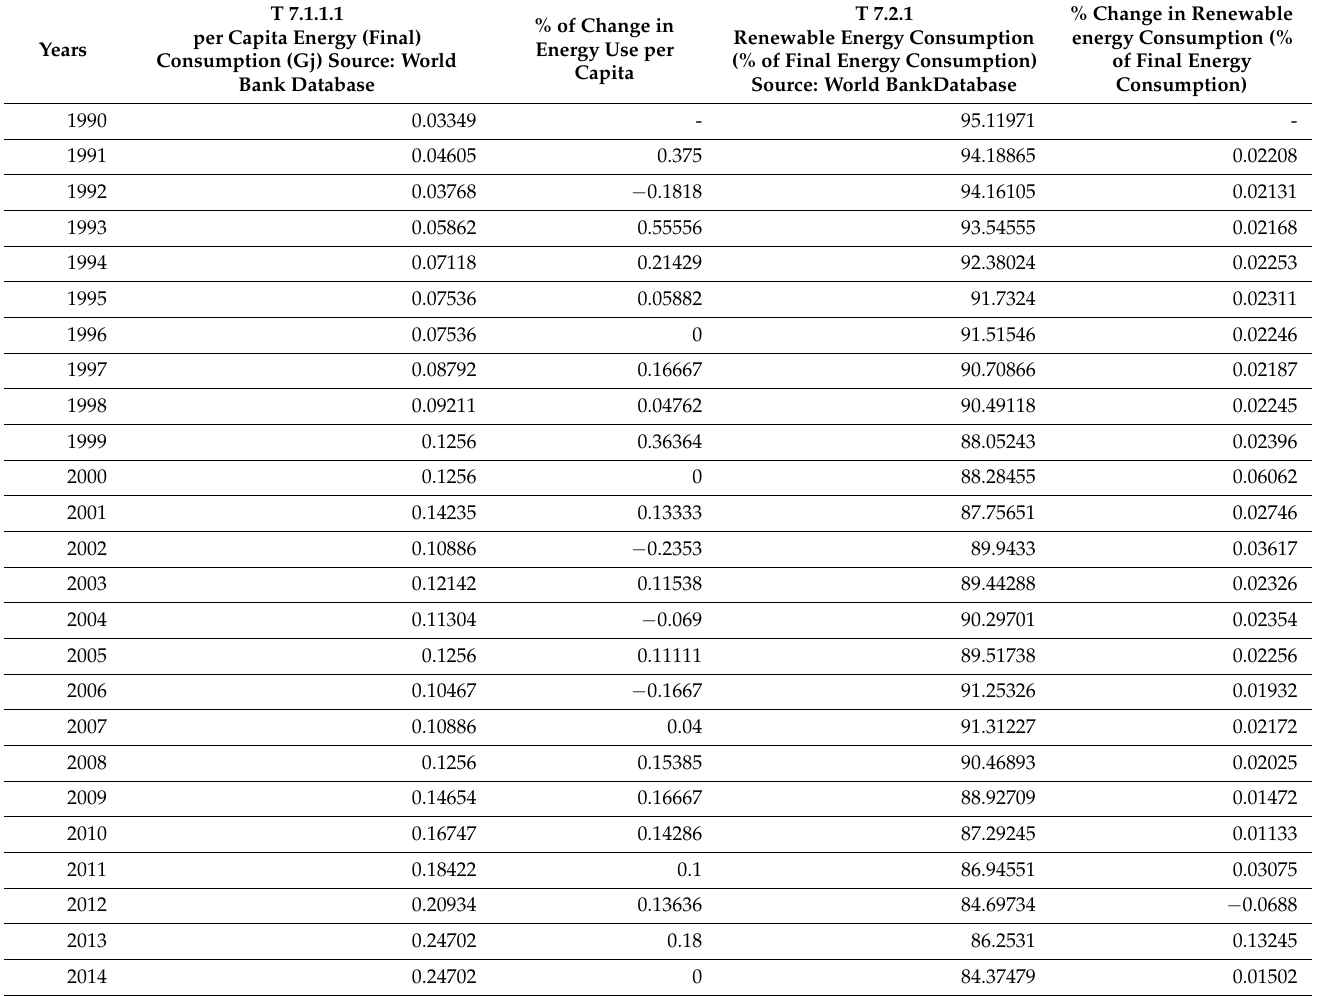
Table A2. Historical dataset for SDG 7 and percent change calculation.